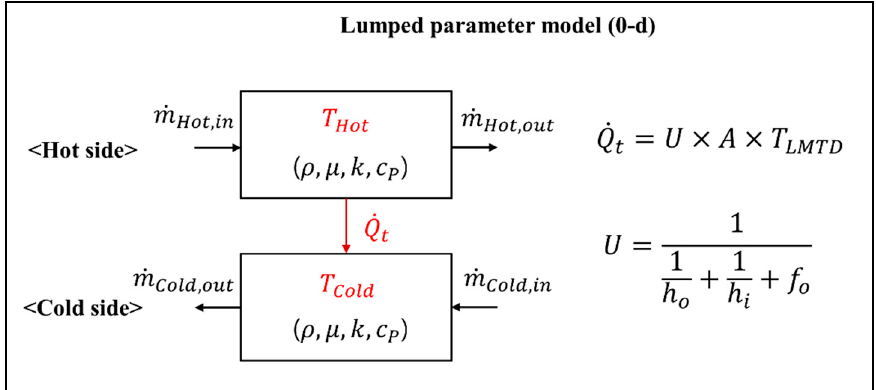
Figure 3. Model outline of the lumped parameter model for a heat exchanger block.